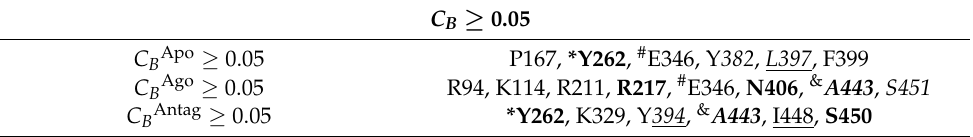
Figure 6. Network centrality analysis for GDH states. ( A ) Betweenness ( C B ), ( B ) closeness ( C c ), and ( C ) degree ( C D ) centralities for each residue of the GDH complexes are shown. The dotted line represents the cutoff value C B = 0.05. ( D ) Residues with high C B ( ≥ 0.05) are depicted as spheres on the minimal energy structure of apo GDH. Gray, dodger blue, and salmon spheres represent the residues with high C B values in the apo, agonist-, and antagonist-bound GDH states, respectively. Other residues that are commonly present in the apo and agonist-bound GDH states, the apo and antagonist-bound GDH states, and the agonist- and antagonist-bound GDH states are shown in pale green, wheat, and purple, respectively. Table 1. List of important residues satisfying the condition ( C B ) ≥ 0.05 are shown. Mutation data available for residues are shown in bold. Residues with | C B Apo − C B Ago | ≥ 0.02 are underlined. Residues with | C B Apo − C B Antag | ≥ 0.02 are